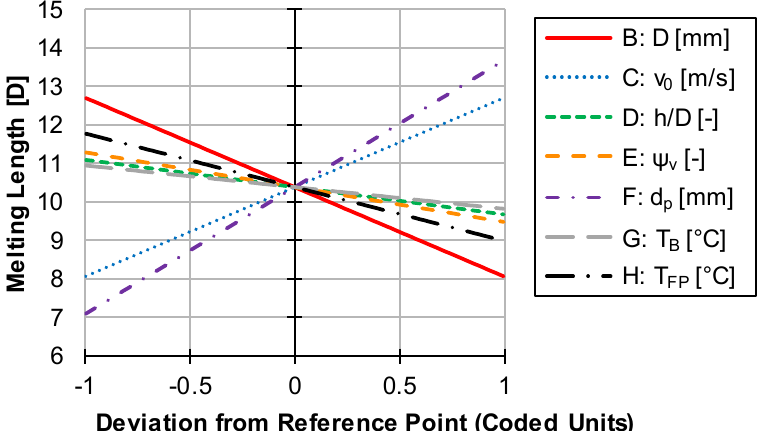
Figure 18. Perturbation plot of design of experiments for verification.